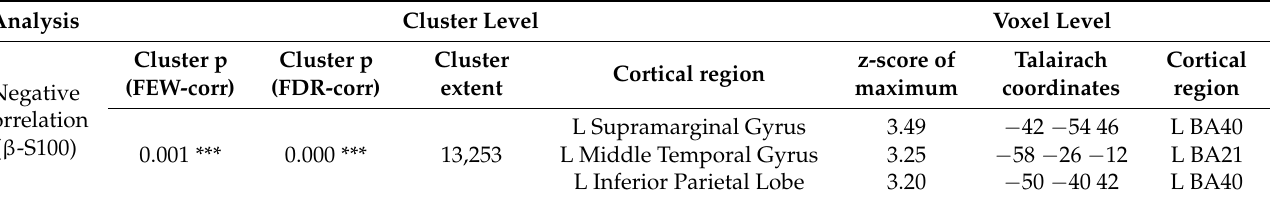
cortical region where the voxel is found are all reported for each significant cluster. In the Voxel level section (right), all coordinates of the correlation sites (with z-score of the maximum correlation point) and the corresponding subcortical region are reported for each significant cluster. L: left; R: right; FEW: Familywise error; FDR: False discovery rate; BA: Broadman Area, *** = p ≤ 0.001.